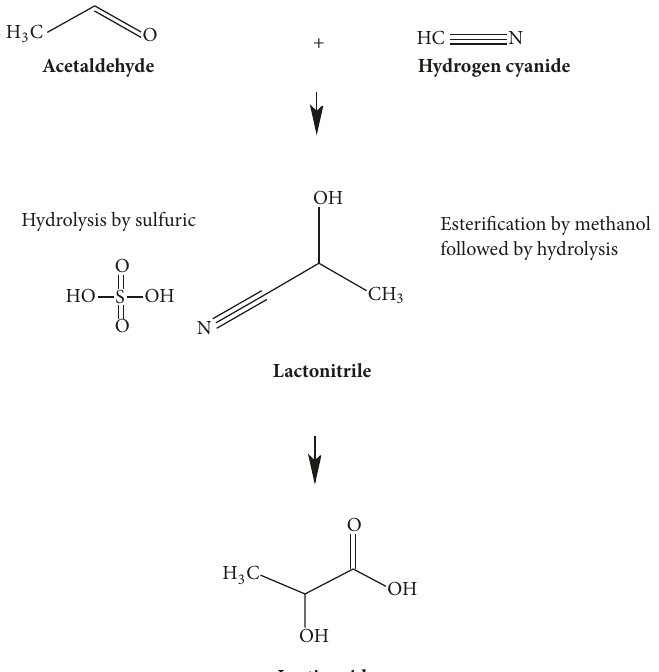
Figure 2: A schematic presentation of production of Lactic Acid by chemical process.